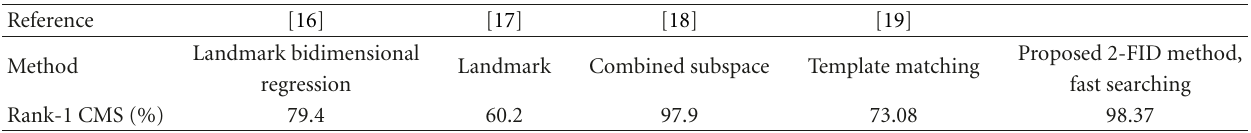
Table 7: List of the referenced results based on release 2003 of FERET database.